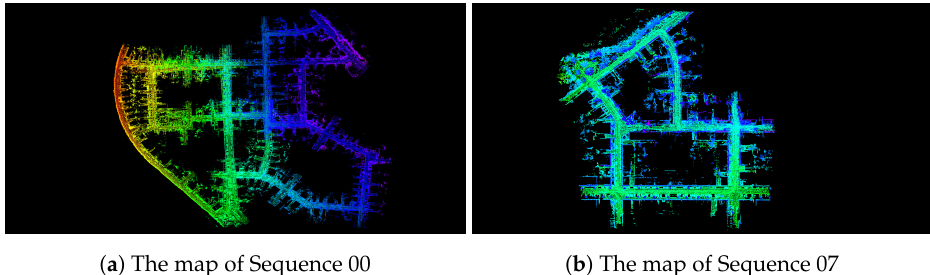
Figure 11. The map of two